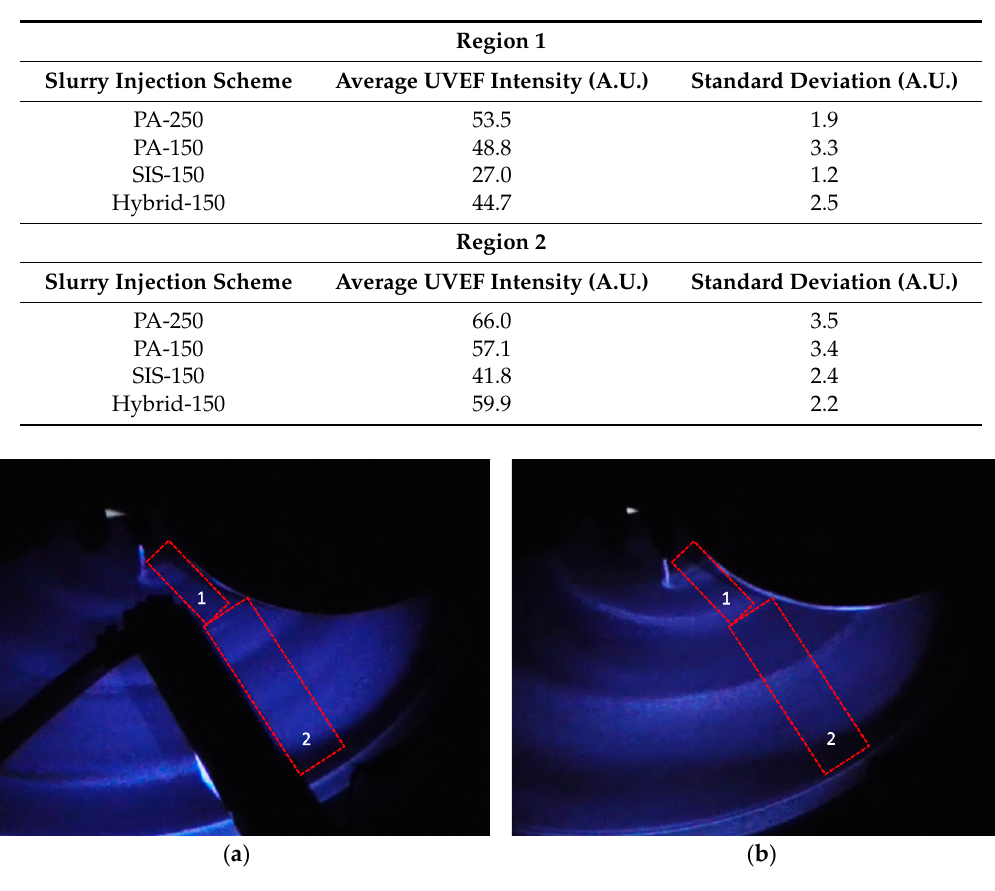
Table 1. Summary of ultraviolet enhanced fluorescence (UVEF) images analysis.